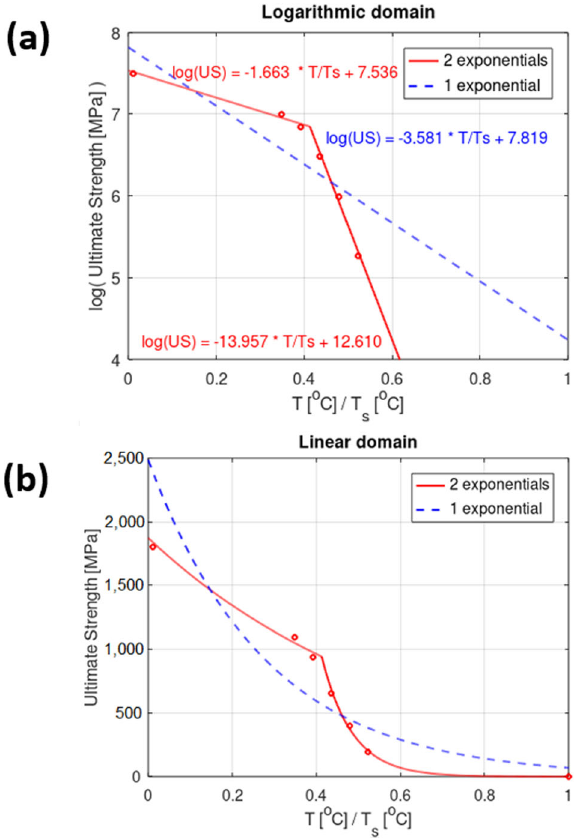
Fig. 4 Quanti fi cation of modeling accuracy of the bilinear log model, for the composition, No. 18, from Table 2 (HfMoNbTiZr), and comparison of the modeling accuracy to that of a model with a single exponential. Panel ( a ) compares the modeling accuracy of the bilinear log model to that of a single exponential in the logarithmic domain, whereas panel ( b ) presents corresponding comparison for the linear domain.